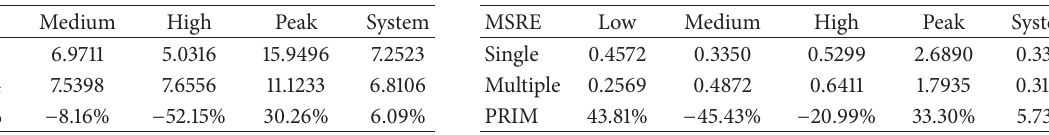
Table7:PerformanceevaluationresultsofMSREbetweenthesingle and the two-stage multiple SVM in June